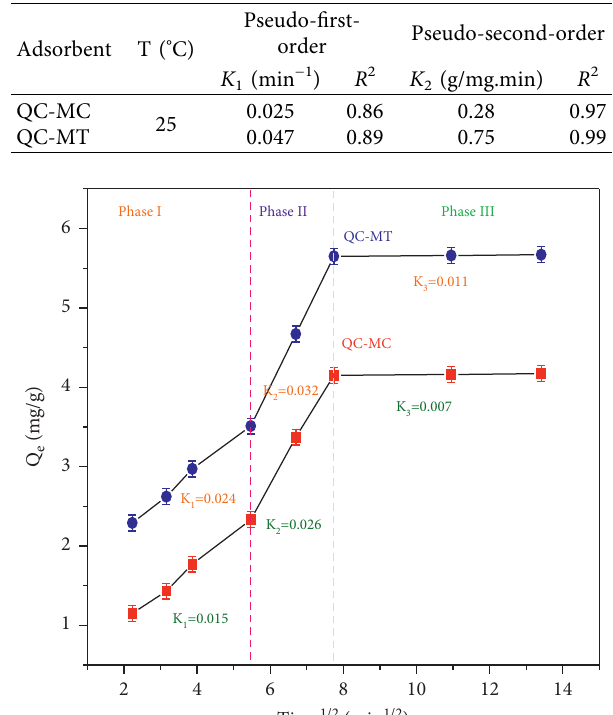
Figure 8: Kinetic models for adsorption of Cd (II) on QC-MC and QC-MT. (a) PFO and (b) PSO ( V � 100mL, T � 25 ° C, C m � 1.5 g, and pH � 5). Table 3: Kinetic parameters of QC-MC and QC-MT.